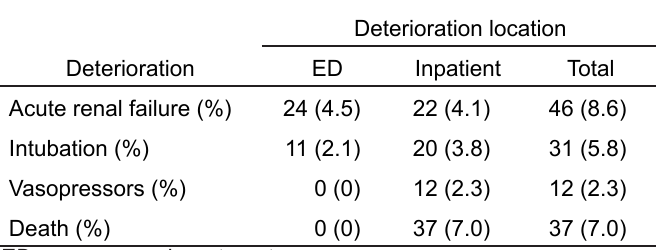
course. Some patients had more than one deterioration event.